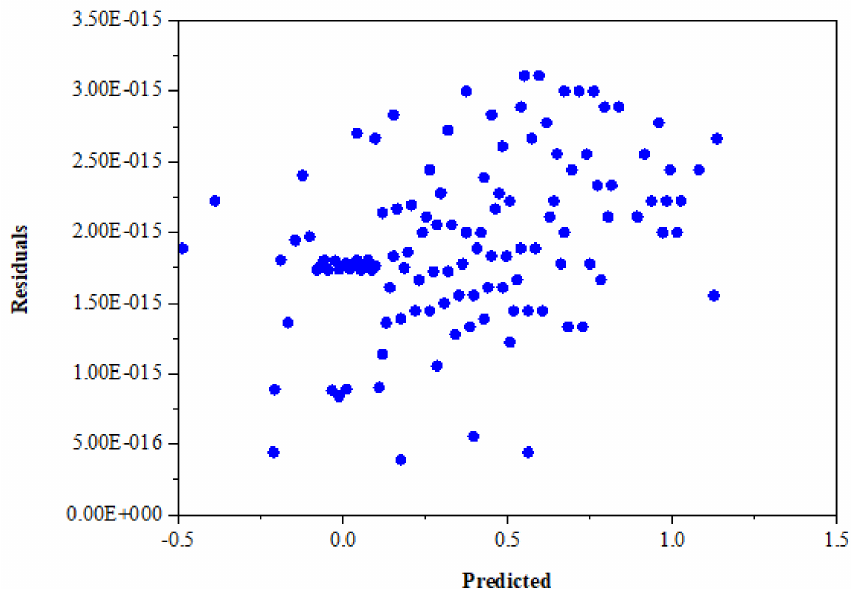
Figure 18. Residuals versus fitted values in the predicted mean vote for patients (PMVp).